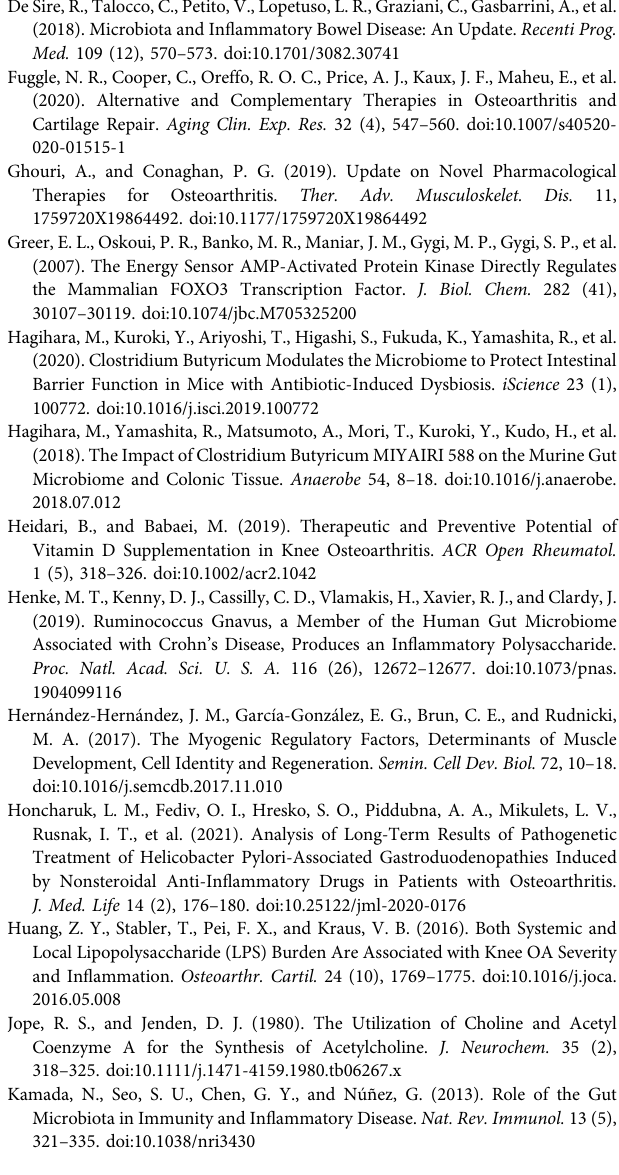
Supplementary Figure S1 | Effects of MY on the gut microbial composition at genus level. The heat map of the prominent OTUs (top50) assigned to genus level between the OA and OA+MY groups. Supplementary Figure S2 | The functional analysis of differential gut microbiota. SupplementaryFigureS3| Theassociatedheatmapbetweenthefecalbacteriaat genus level and the identi fi ed differential metabolites. Different colors and